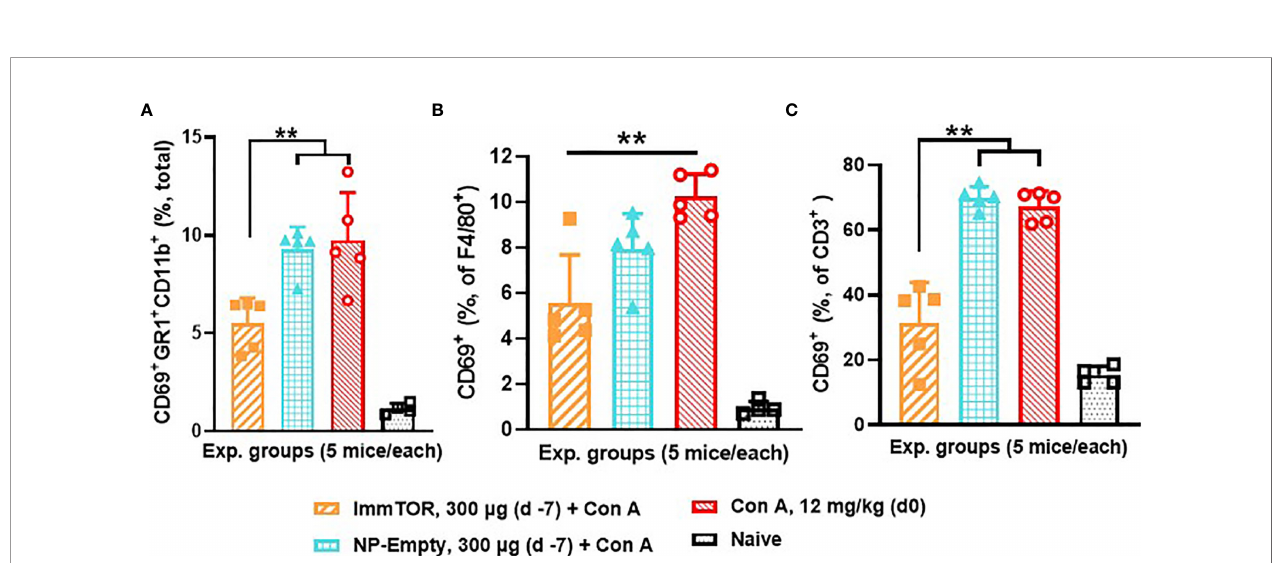
FIGURE 9 | ImmTOR pretreatment diminishes hepatic neutrophil in fi ltration as well as hepatic macrophage and T cell activation after concanavalin A challenge. Three groups of mice (5/group) which were either untreated or pre-injected with ImmTOR or NP-Empty particles (300 µg) were challenged with concanavalin A (12 mg/kg, i.v.) 7 days after the treatment, sacri fi ced 12 hours later, livers processed to single cell suspensions and analyzed by FACS. (A) – fraction of activated neutrophils (identi fi ed as CD69 + GR1 + CD11b + ) out of total hepatic cells; (B, C) – fractions of activated (CD69 + ) macrophages and T cells (identi fi ed as F4/80 + and CD3 + cells, correspondingly) are shown vs. that of naïve (no ImmTOR, no Con A) mice with statistical difference between groups indicated (** – p<0.01; Mann- Whitney